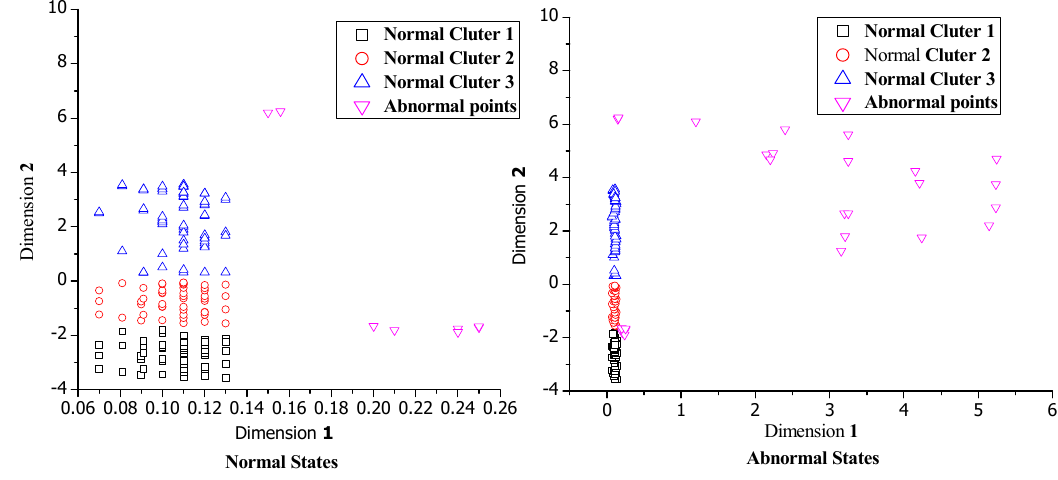
Figure 6. The clustering results of different types of data.